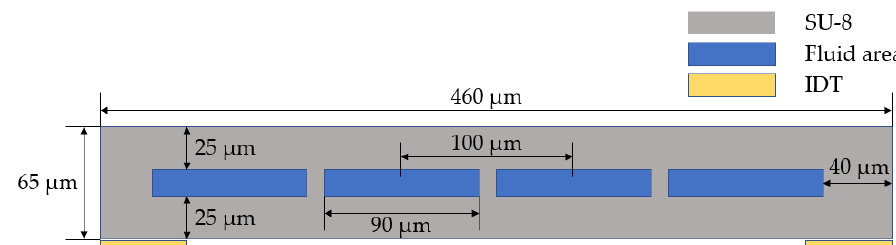
Figure 1. Crossover schematic diagram of the channel [8].